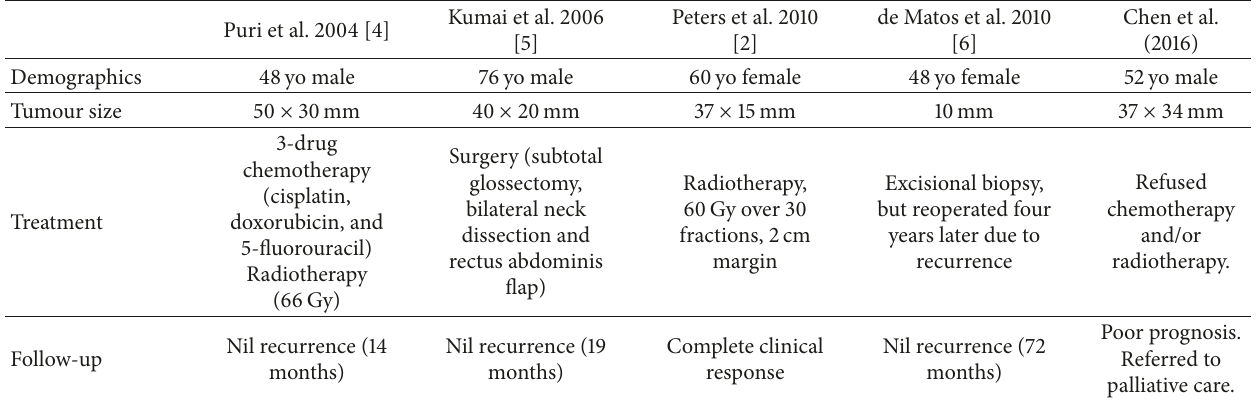
Table 1: Cases found in the literature of epithelial-myoepithelial carcinoma in the tongue. Puri et al. 2004